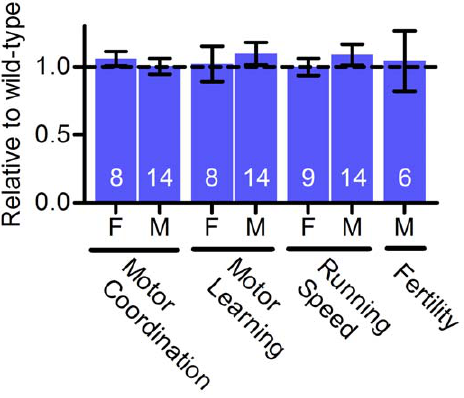
Figure 1. Young (3 months old) Risp + /P224S mice have unim- paired physiological performance. The sex of the mice (F for female, M for male), as well as the type of test, are indicated below each bar. Mice were tested for motor coordination (average of 3 trials after 2 days of training on a Rota-Rod), motor learning (Rota-Rod performance on day 3 relative to day 1), running speed (the maximum speed mice could maintain on a powered treadmill) and male fertility (number of pups sired by Risp + /P224S males with wild-type females). All measure- ments were made in wild-type/heterozygote littermate pairs, and results are expressed as the effect of Risp heterozygosity relative to wild-type within each pair. Sample sizes (number of littermate pairs) are shown superimposed on each bar. Actual (not normalized) values are shown in Table S2.